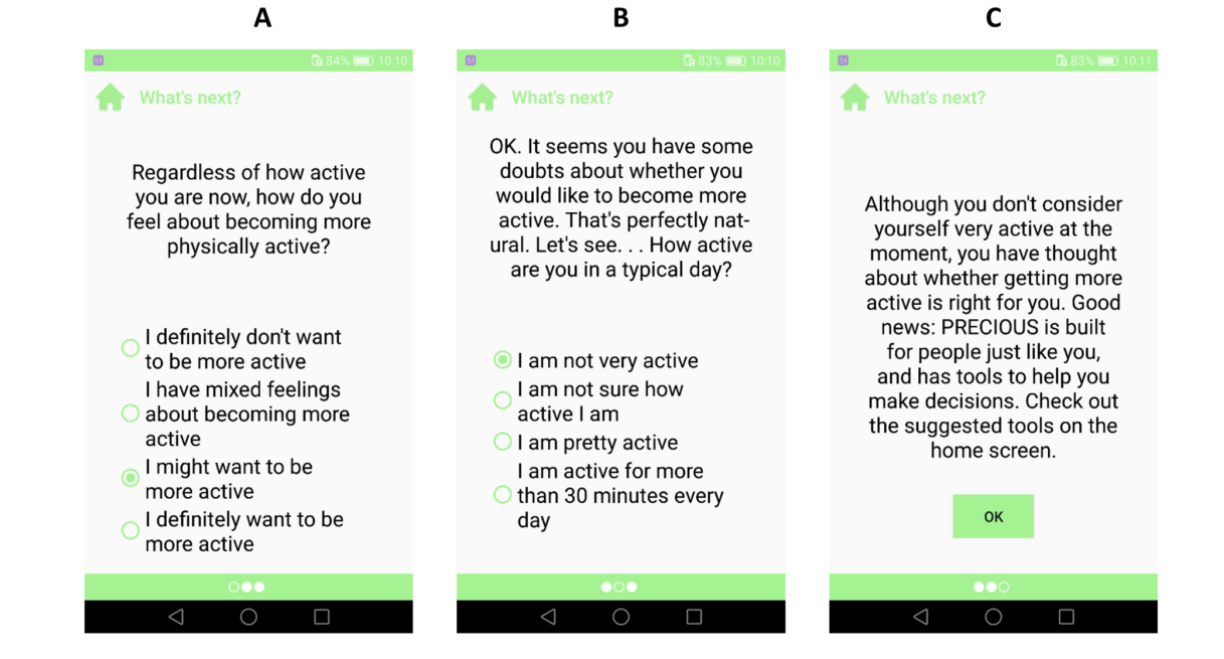
Figure 5. What’s Next tool. This tool assessed a user’s stage of change for physical activity and directed users to either motivational or self-regulatory features based on their